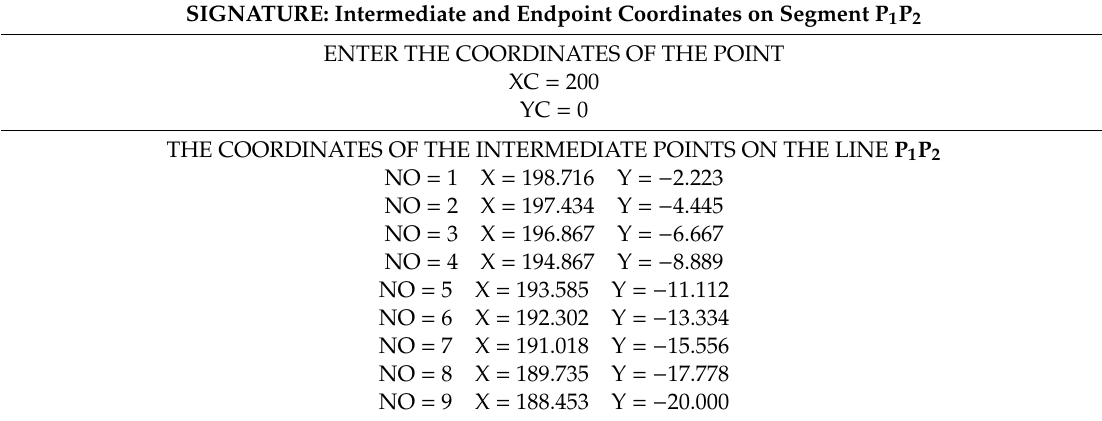
Table 2. The results of automatic calculation of characteristics points P 1 P 2 and E 1 E 2